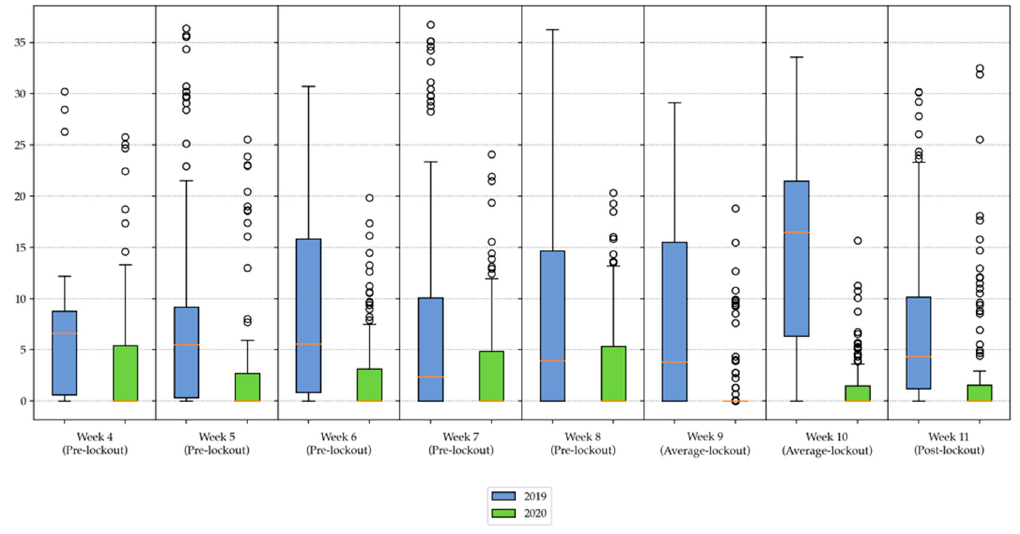
Figure 20. Weekly boxplots of the standard deviations between zonal prices in the observed weekdays.